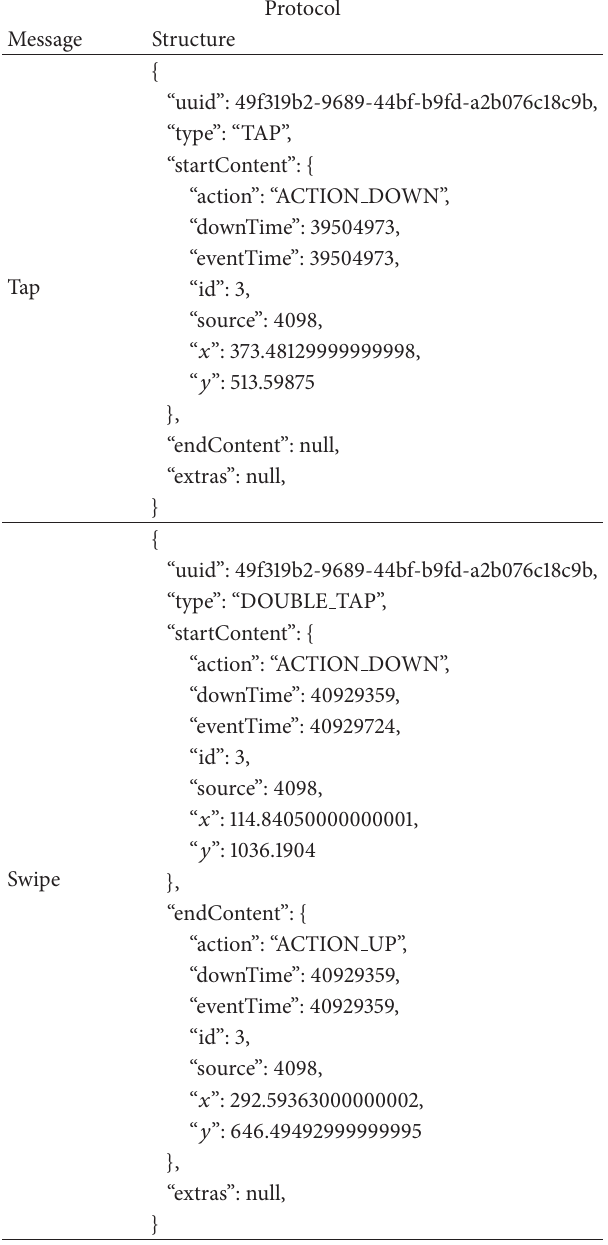
Table 3: Protocol messages details.